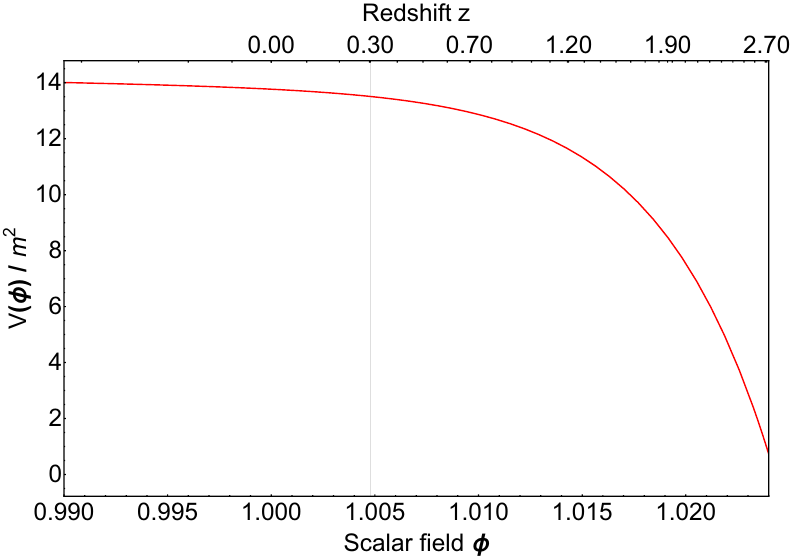
Figure 3. Profile of the scalar field potential V ( φ ) in the JF equivalent scalar-tensor formalism of the f(R) modified gravity. The form of V ( φ ) ) is inferred from the behavior of H 0 ( z ) (Equation (9)). Note that V ( φ ) / m 2 is a dimensionless quantity. A flat profile of V ( φ ) occurs only at low redshifts, for 0 < z (cid:46) 0.3 or equivalently φ (cid:46) 1.005. Note, also, the non-linearity of the scale for the redshift axis on top, considering the relation (22) between φ and z . In this plot, η =